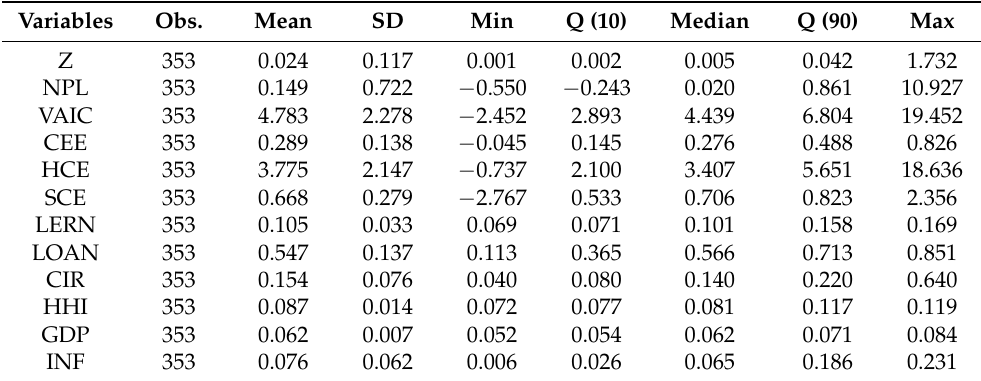
Table 1. The descriptive statistics of